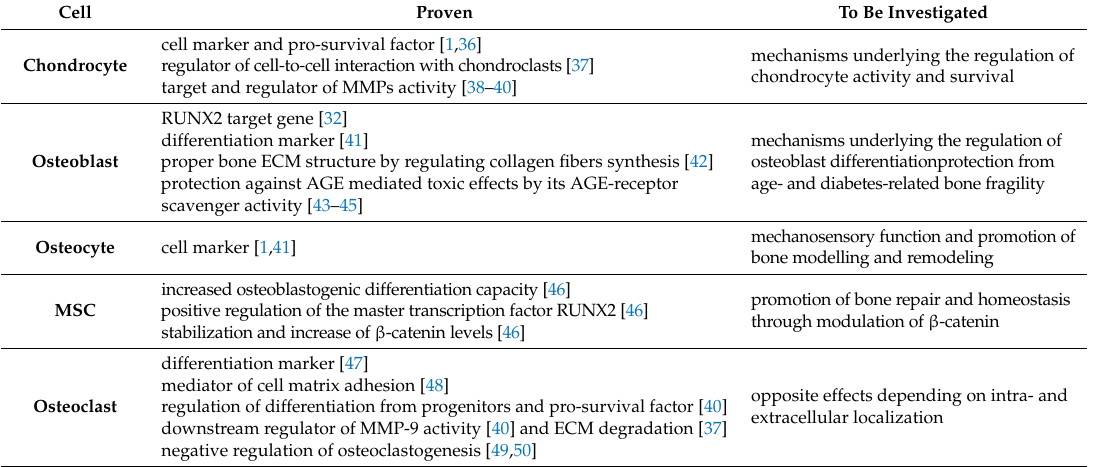
Table 1. Proven roles of galectin-3 in bone biology and supposed functions, to be investigated, in the pathophysiology of bone